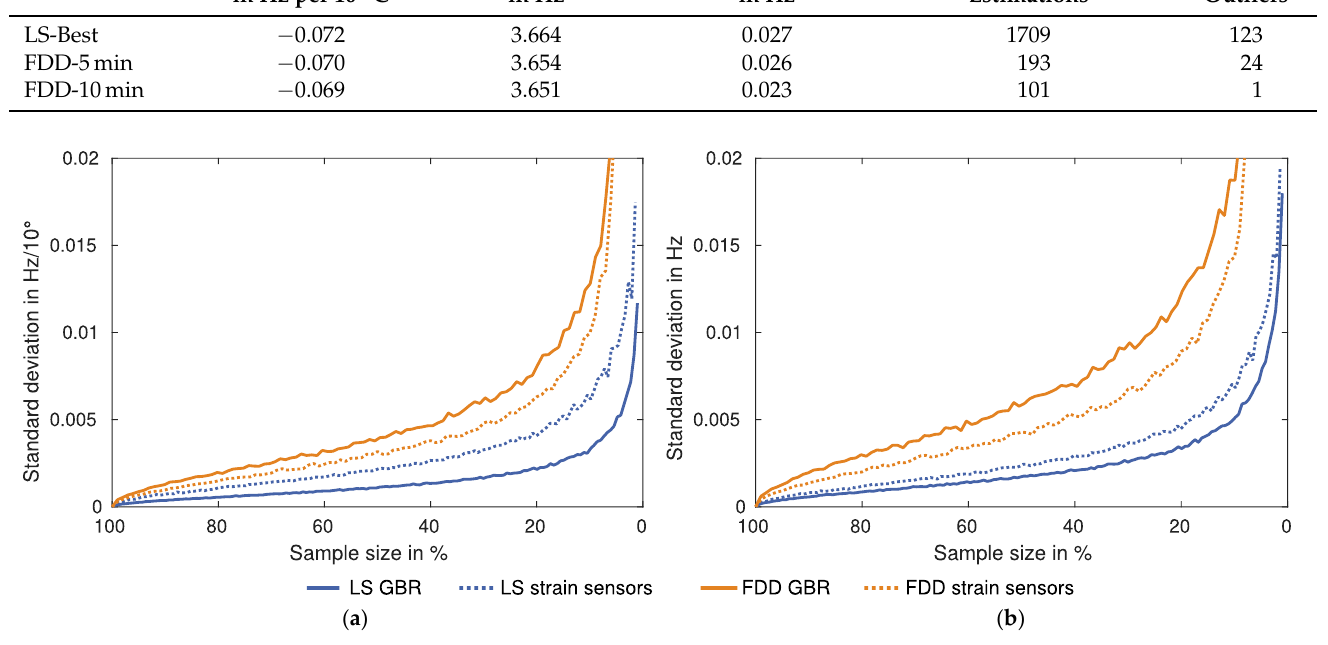
Figure 7. Variation of the linear regression depending on sample size. The least squares (LS) uses the best approach for GBR and the mean approach for the strain sensors. The FDD has a time window of 10min: ( a ) Variation of slope parameter. ( b ) Variation of offset